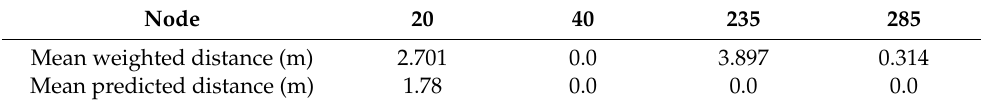
Table 10. Inference mean values for nodes 20, 40, 235, and 285.